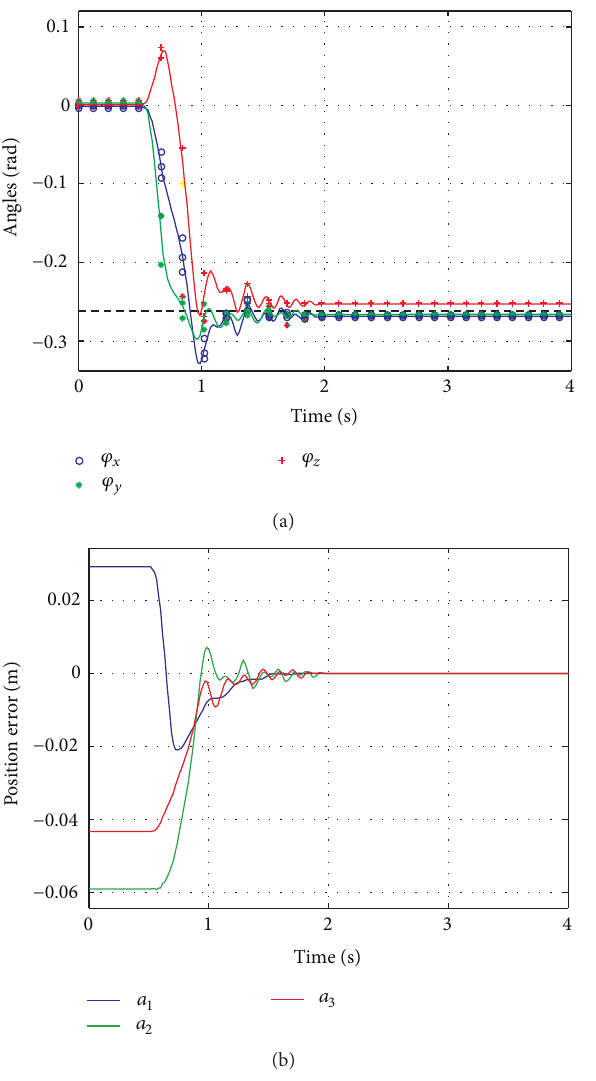
Figure 14: Task-space PID with gravity compensation: platform’s trajectory in workspace (a) and joint space errors (b).